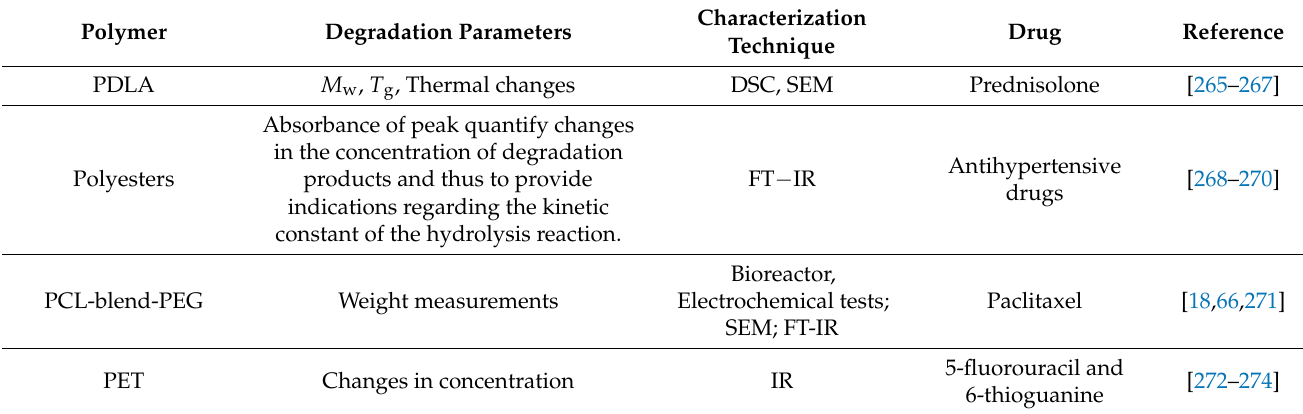
Table 5. Characterization techniques used to study polymer degradation behavior.